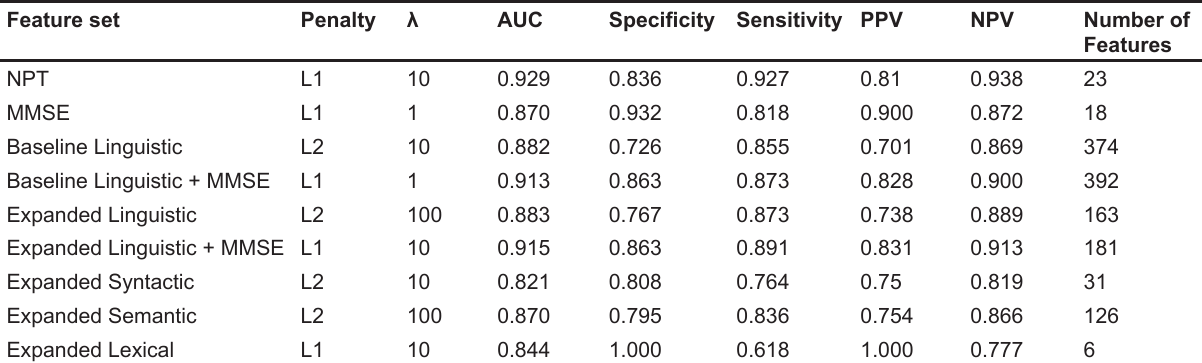
Table 2. Model performances for classification of presence of any cognitive impairment among different feature sets (MCI and dementia are grouped together). Thresholds balance out the TPR and FPR Feature set Penalty λ AUC Specificity Sensitivity PPV NPV Number of